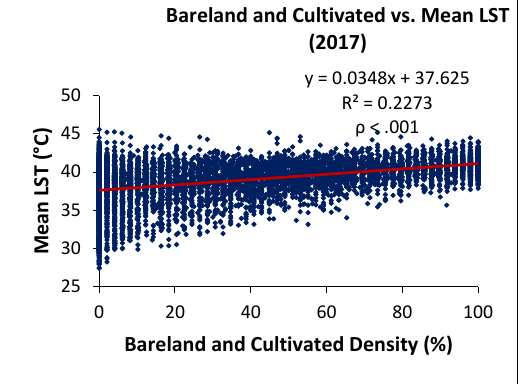
Figure 10. Scatter plots between impervious surface, green space density and mean LST in Seville City. Table 2. Result of the OLS MLR analysis (Dependent Variable: Mean LST; N = 9216). 1987 OLS MLR